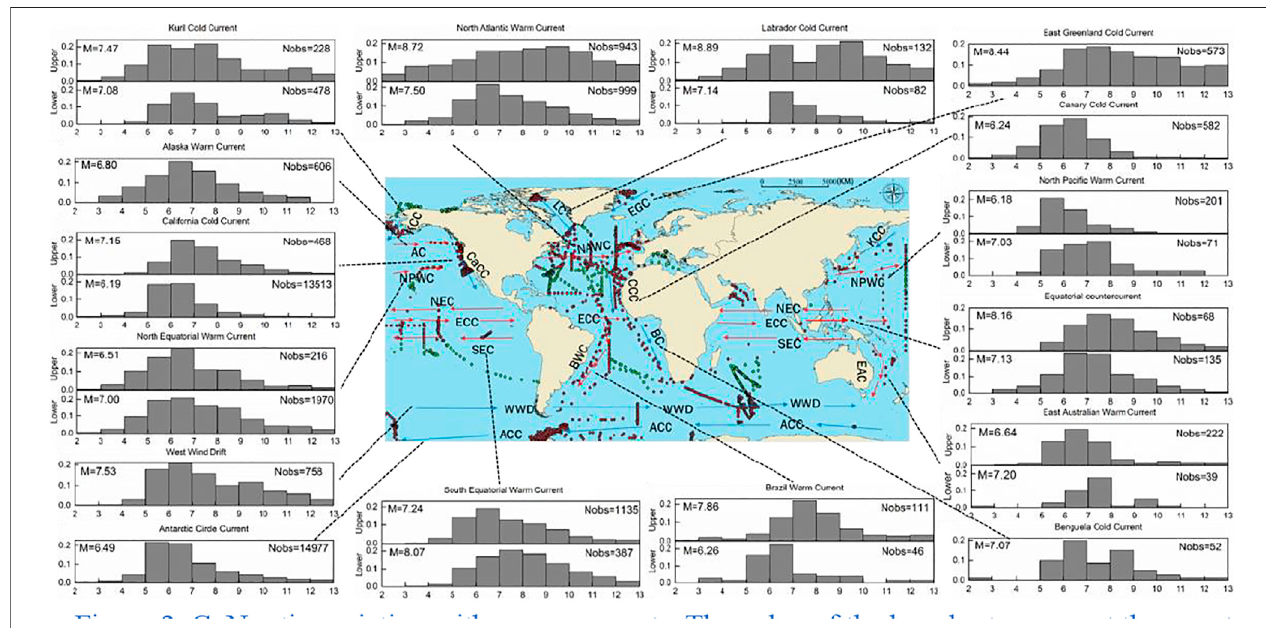
FIGURE 2 | C-to-N ratio variation with ocean currents. The value of the bar chart represents the count percentage of the histogram bins.